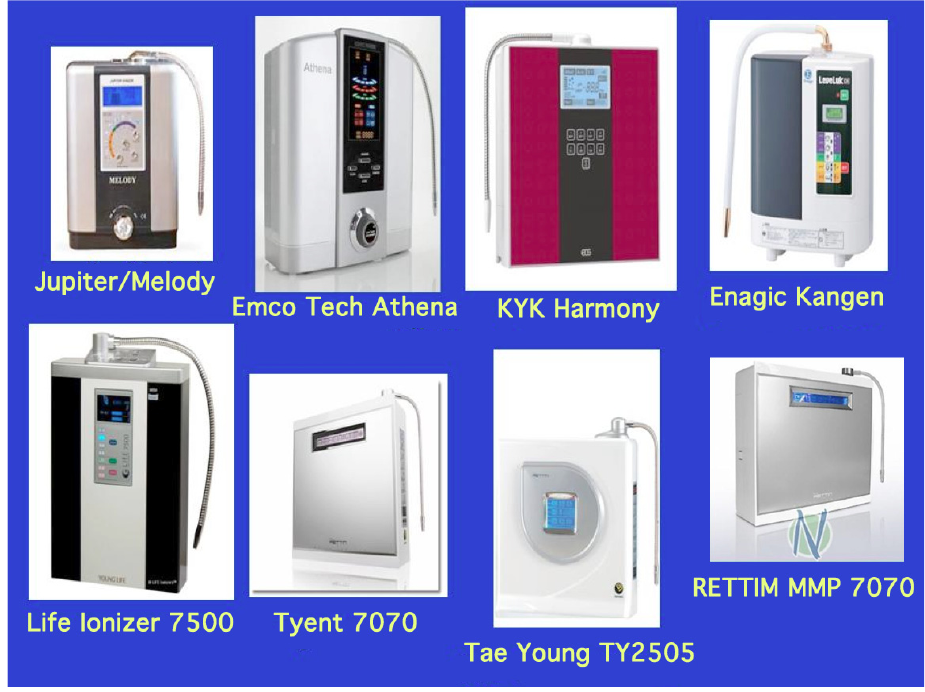
Figure 1. Some electrolyzed water generators available on the market.